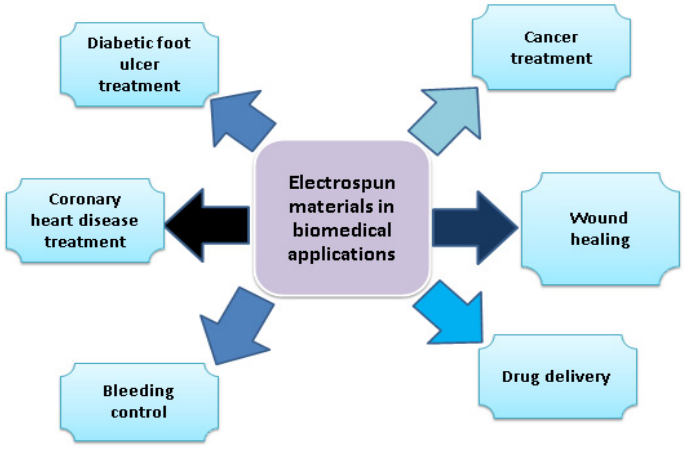
Figure 5. Biomedical applications of electrospun materials.